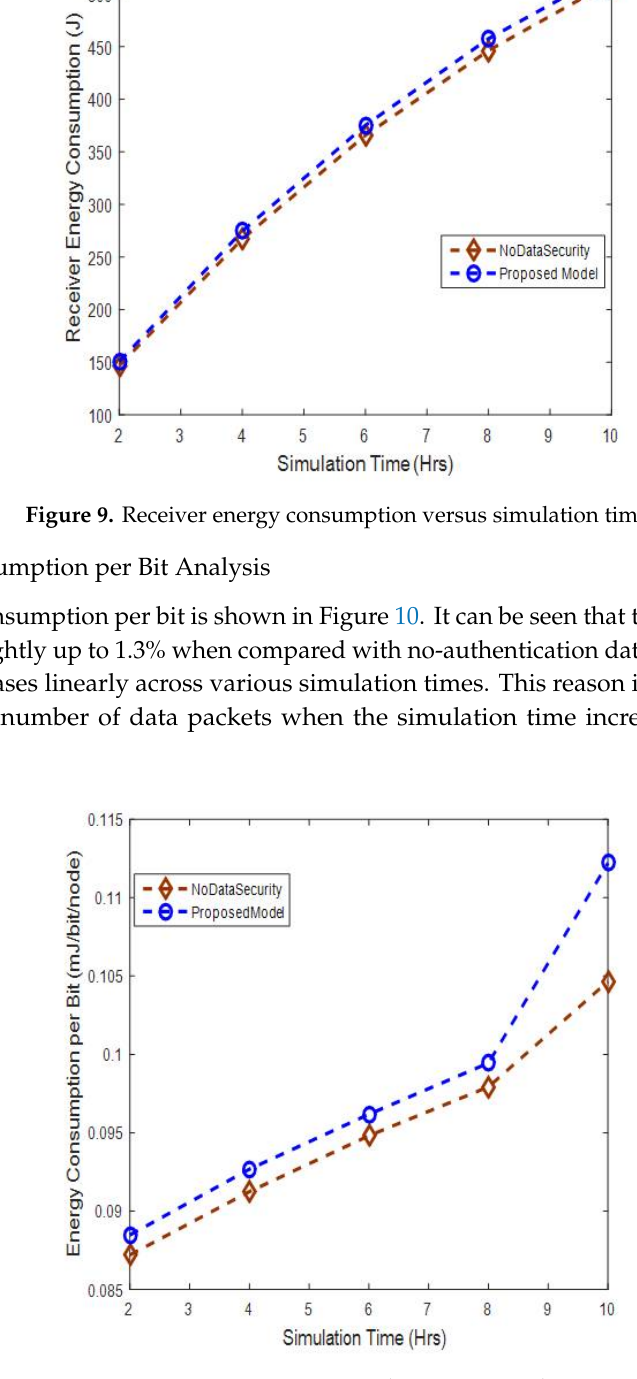
Figure 11. Energy consumption per sender versus simulation time. 6. Optimized Model In the proposed model, each time when the message is sent, the node generates the new secret key for trustworthiness protection. Implementation of such a model requires increased processor strength and memory in nodes, as well as more energy. Resource use in the wireless sensor network with the implemented model depends, also, on selected parameters in the preparation phase for model implementation. This is primarily important for selected key lengths and algorithms, estimated risk, frequency of data sending and management messages. In order to make the model